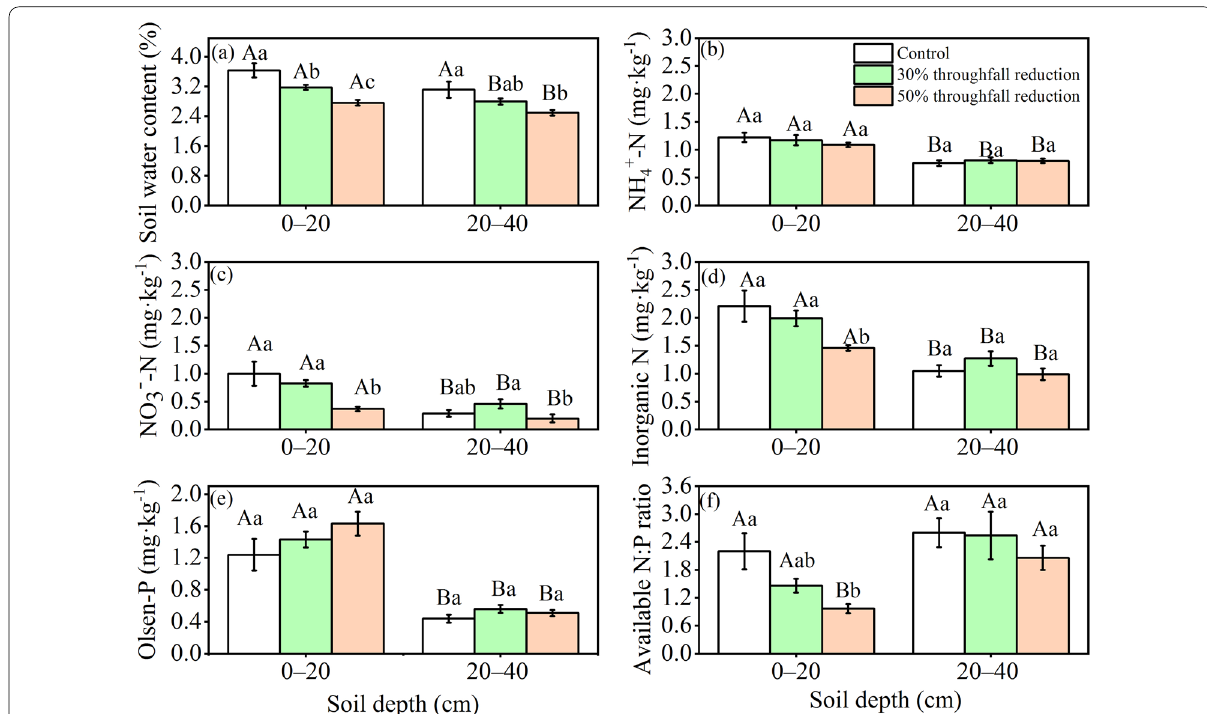
Fig. 3 Effect of drought on soil water content, NH 4 + ‑N, NO 3 − ‑N, inorganic N, Olsen‑P concentrations and available N:P ratio (mean different soil depths. Different uppercase letters above the bars indicate significant differences between soil layers at each drought treatment, and different lowercase letters above the bars indicate significant differences among three drought treatments at each soil